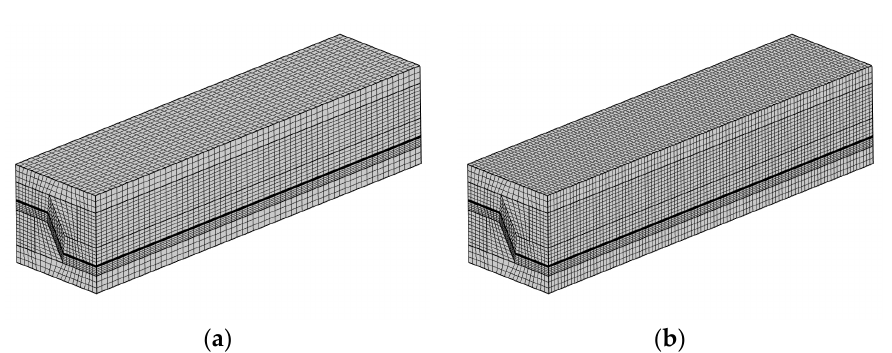
Figure 2. ( a ) Mesh number of 46,200; ( b ) mesh number of 77,000.